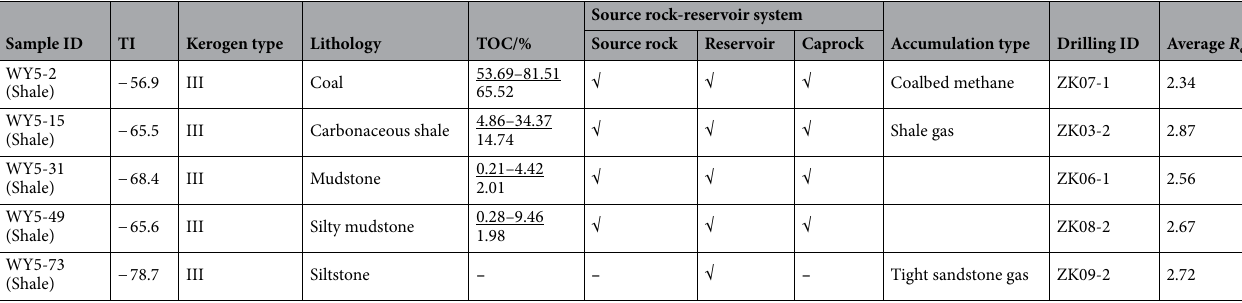
Table 2. Organic geochemical parameters of source rock–reservoir